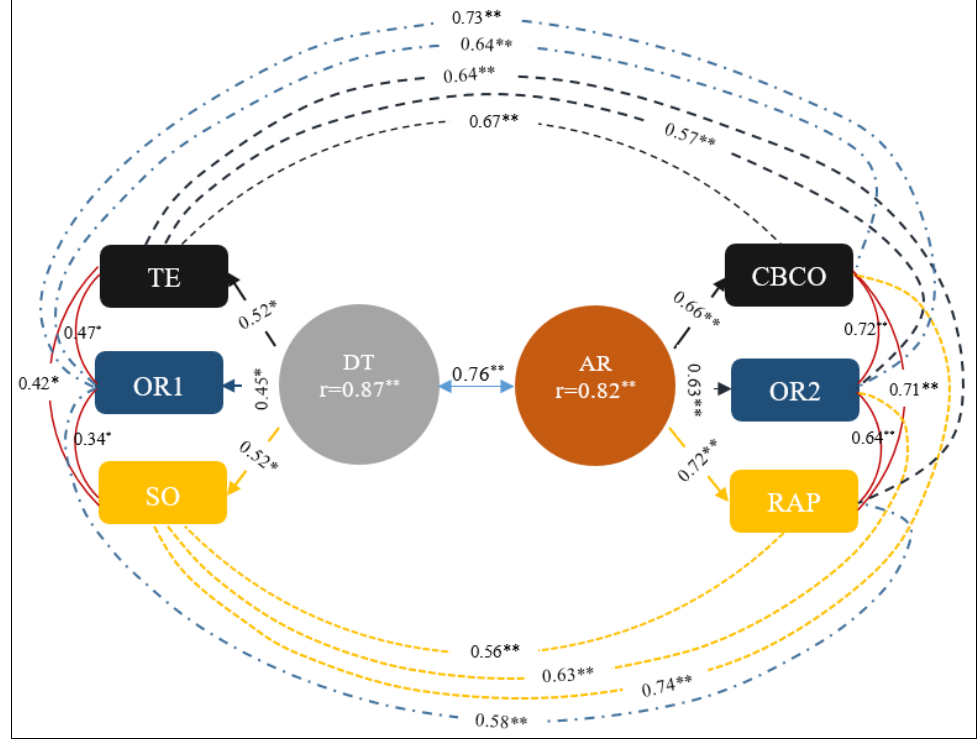
Figure 4. Measurement model correlation between variables in digital transformation and administrative reform